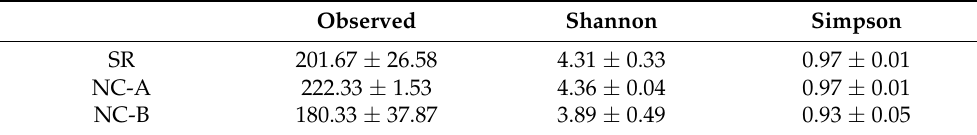
Table 2. Richness (observed species) and diversity indices (Shannon and Simpson) based on Illumina MiSeq sequencing data (mean ± standard deviation) of soil samples taken from Sorac á (SR) and Nuevo Col ó n (steep slope plot at higher altitude: NC-A; flat plot at lower altitude: